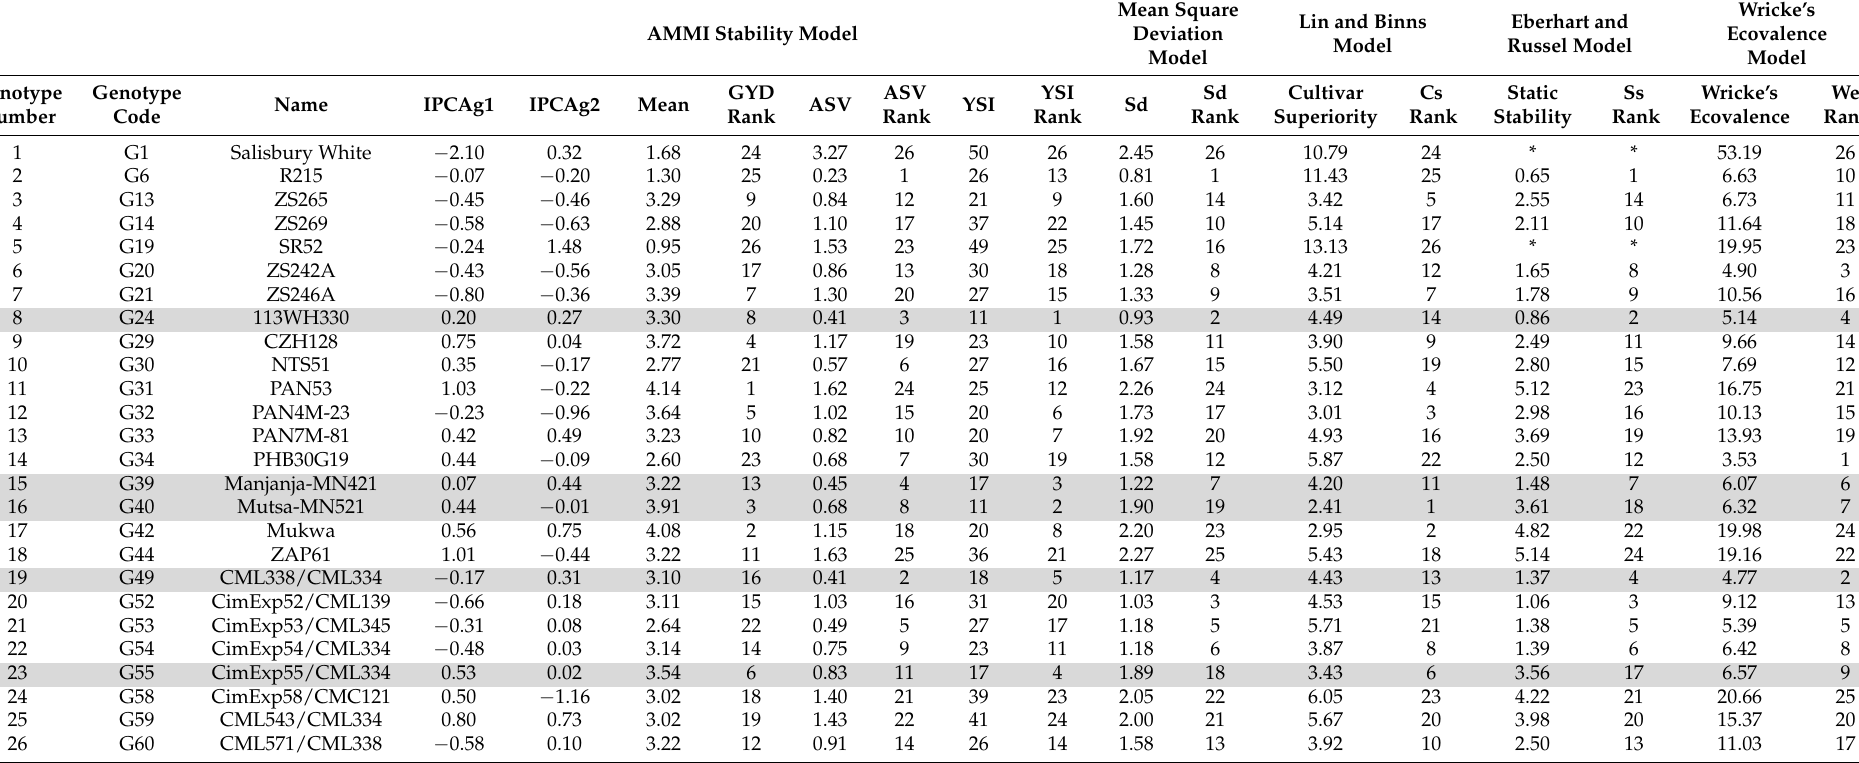
Table 4. Assessment of grain yield stability of hybrids and OPVs evaluated across nine natural fall armyworm infestation environments in Zimbabwe during the 2019–2020 seasons using different stability models. The shaded rows in gray highlight the selections